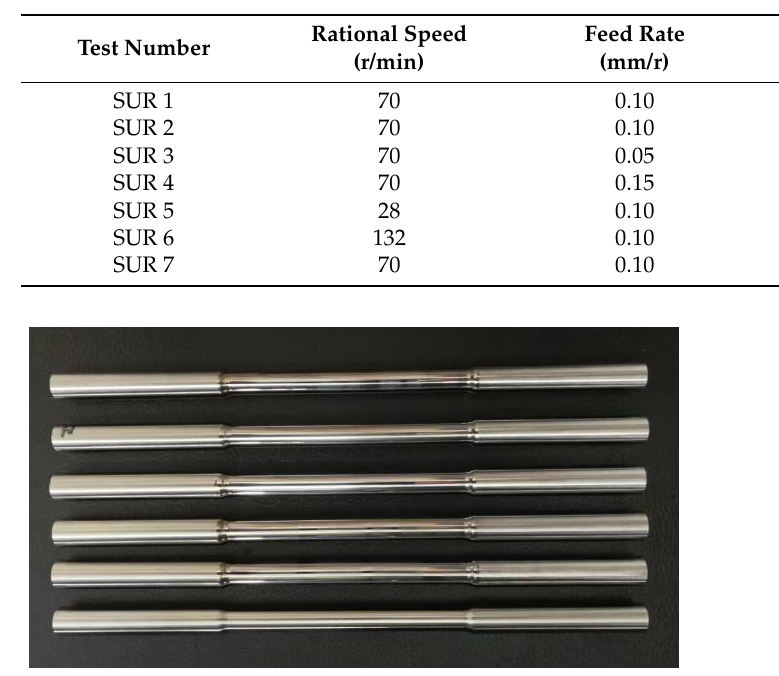
Figure 2. Surface ultrasonic rolling treatment of sample. Table 2. Parameters of surface ultrasonic rolling treatment using single-factor variable method.